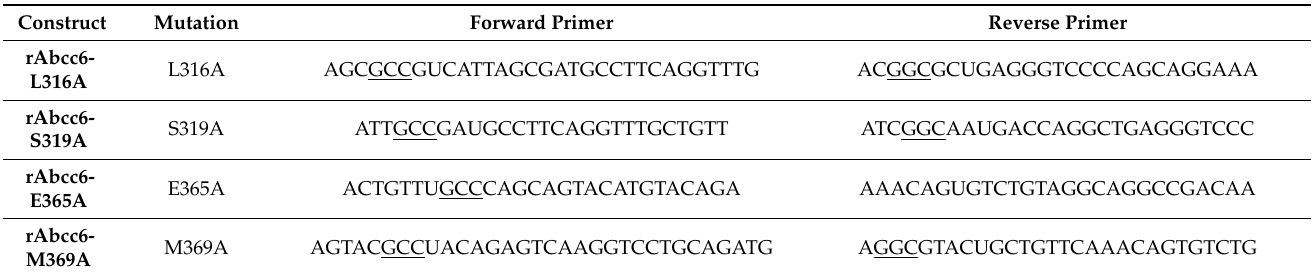
Table 2. Primers used to generate the various rAbcc6